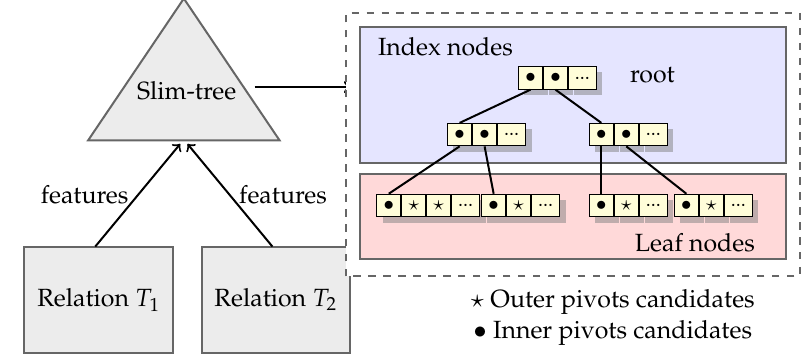
Figure 2. Finding pivots